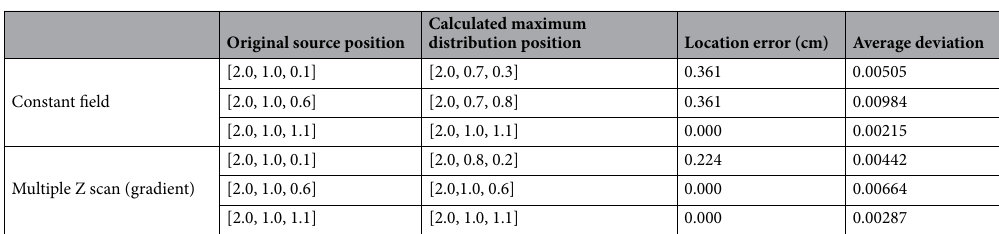
Table 2. Location error and average deviation of the inverse distribution of the constant and gradient field multiple Z scan.